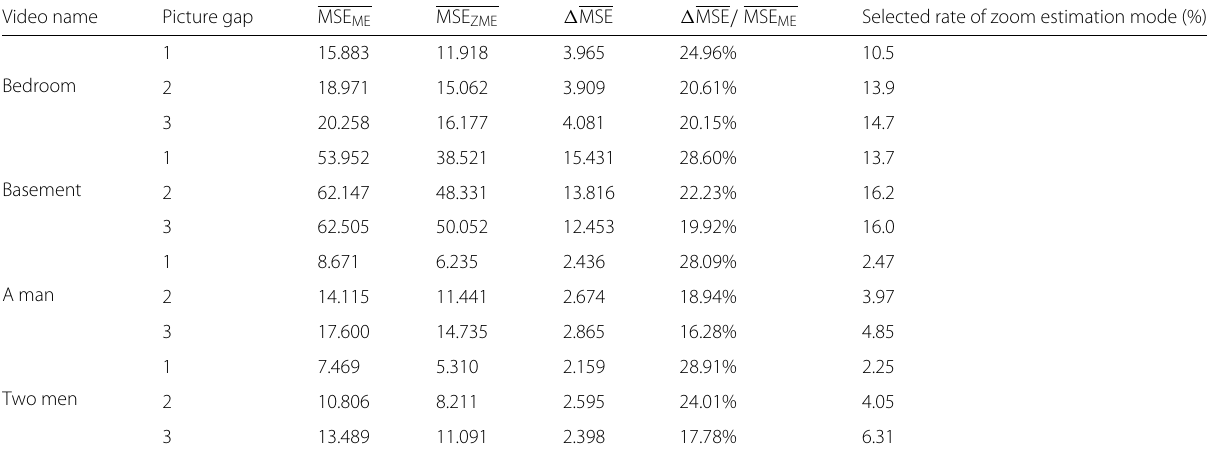
Table 1 Averages of MSEs in color video according to frame gap in 8 × 8 block size